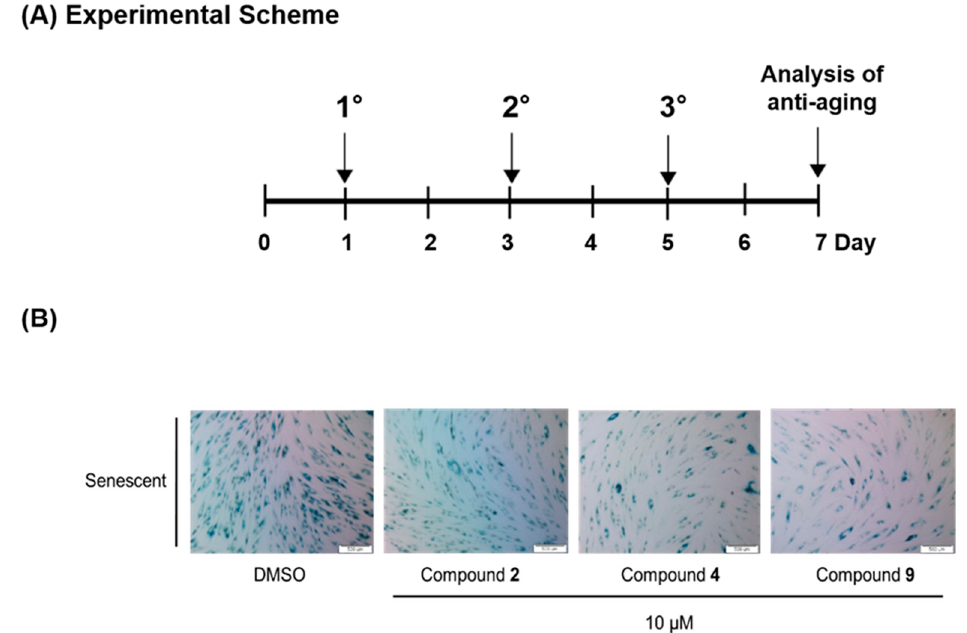
Figure 6. Experimental scheme and the result of the senescence-associated β -galactosidase staining. Senescent HDFs were treated with a vehicle or 10 µ M compounds 2 , 4 or 9 three times over 6 days ( A ). Using an SA- β -galactosidase staining kit (at# 9860; Cell Signaling Technology, Denver, MA, USA), the SA- β -galactosidase-positive cells were stained according to the manufacturer’s instructions. Cells stained for SA- β -gal activity were observed and bright field images were taken with a fluorescence microscope (Olympus ix70, Olympus Corporation, Tokyo, Japan) ( B ). In addition, the quantification of the β -galactosidase staining was provided in the Supplementary Materials (Figure S48).